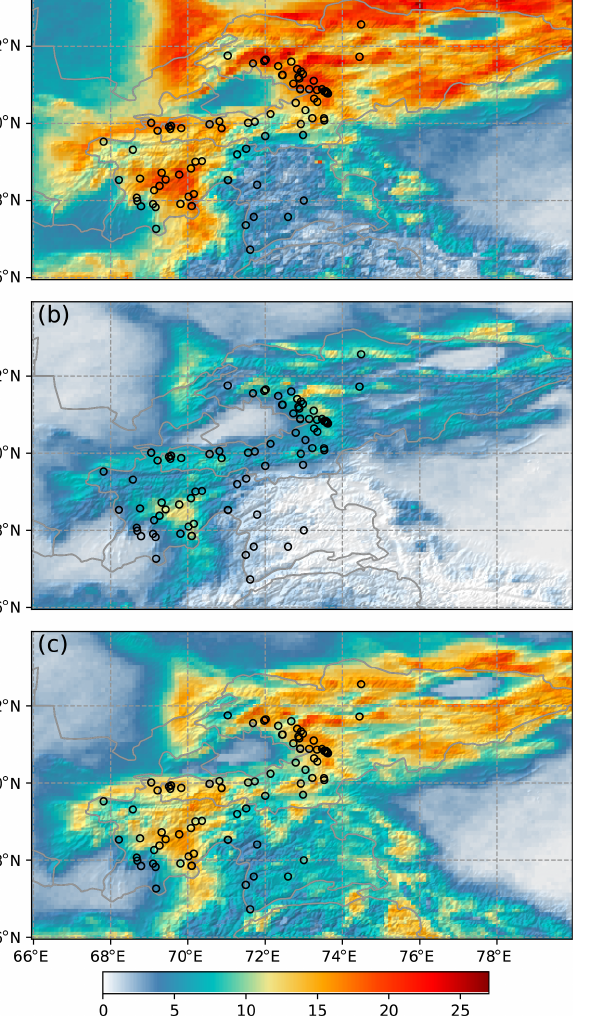
Figure 6. Mean annual exceedance (number of events per year) of (a) I mean = 5 . 05mmd − 1 , (b) I max = 14 . 05mmd − 1 , and (c) Q = 15 . 65mm for the rainfall + snowmelt UTL events. Black circles: landslide events from the GLC and the GFLD. Topographic shading is based on DEM data from